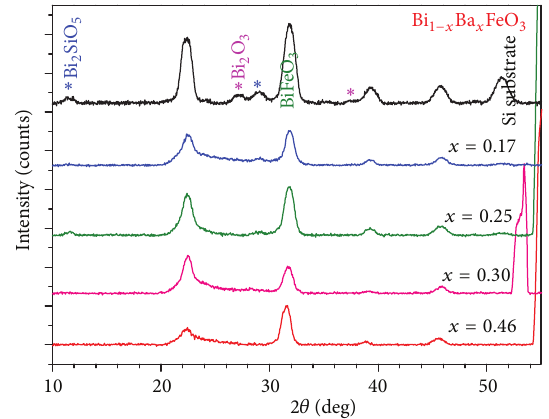
Ba FeO 3 films. x x